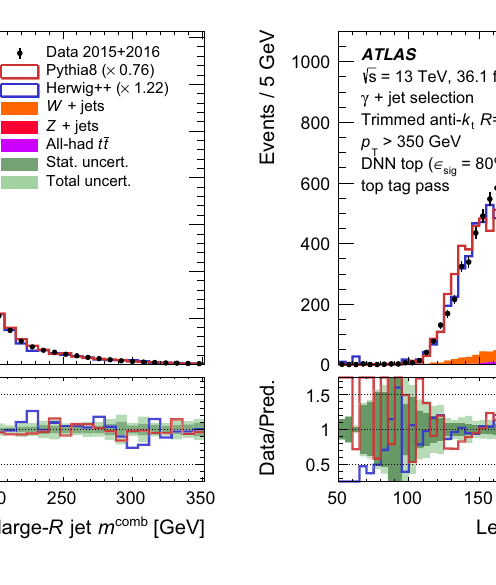
beside the specific sample to which it applies. Systematic uncertainties are indicated as a band in the lower panel and include all experimental uncertainties related to the selection of events, as well as the reconstruc- tion and calibration of the large- R